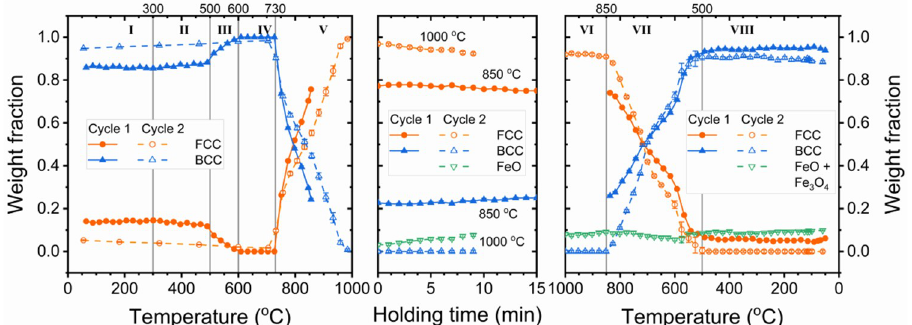
Figure 4. Weight fraction evolutions of constituent phases as a function of temperature/time. The three subsets from left to right correspond to heating, isothermal holding and cooling stages, respectively.